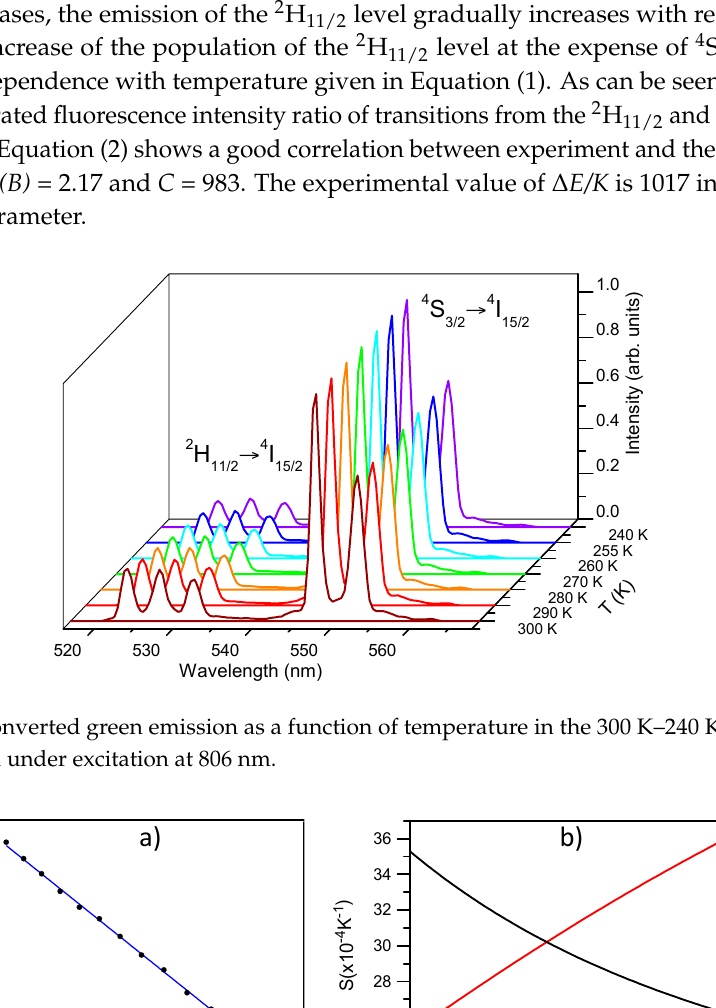
Figure 9. ( a ) Integrated intensity ratio of the green upconverted emissions as a function of 10 3 /T in the 300 K–240 K temperature range. The solid line corresponds to the fitting with Equation (2); ( b ) Sensitivity (red line) and resolution (black line) of the FIR temperature sensor based on La 2 O 2 S:Er 3+ .